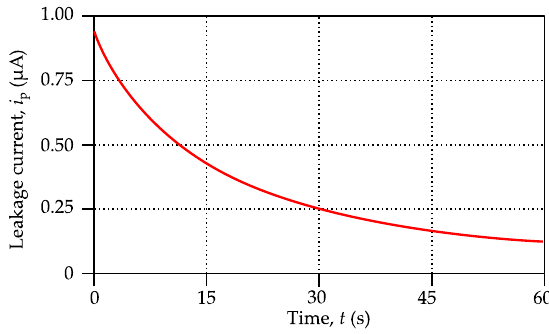
Figure 11. Characteristic i P = f( t ).